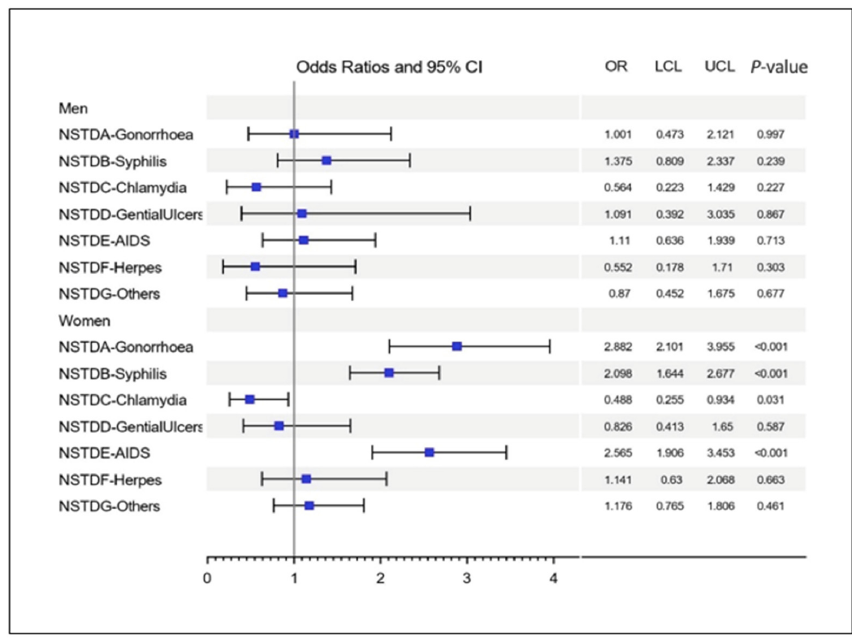
Figure 4. Forest plot presenting odds of testing positive for at least one STI in men and women who reported awareness of an